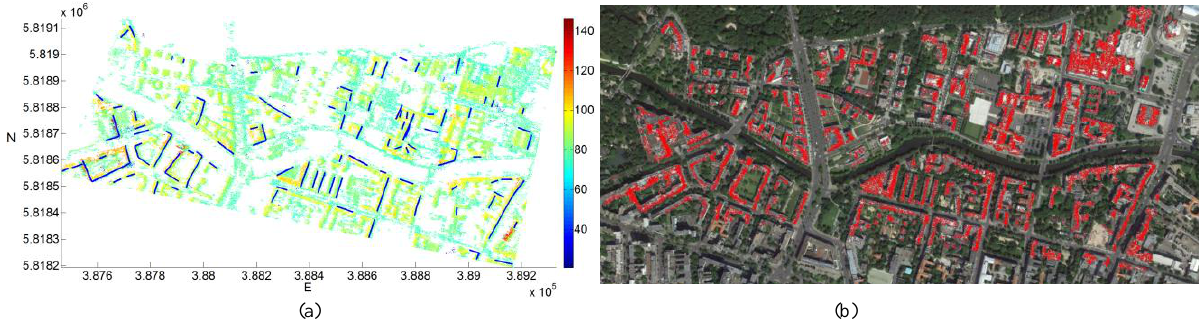
Figure 2: Results of building extraction: (a) Top view of the TomoSAR points in UTM coordinates of the area of interest in Berlin, Germany. Blue lines depict the reconstructed façade segments (longer than 10 meters). Height of TomoSAR points is color-coded [unit: m]; (b) Extracted building points using approach presented in (Shahzad and Zhu, 2015b) overlaid onto optical image ©